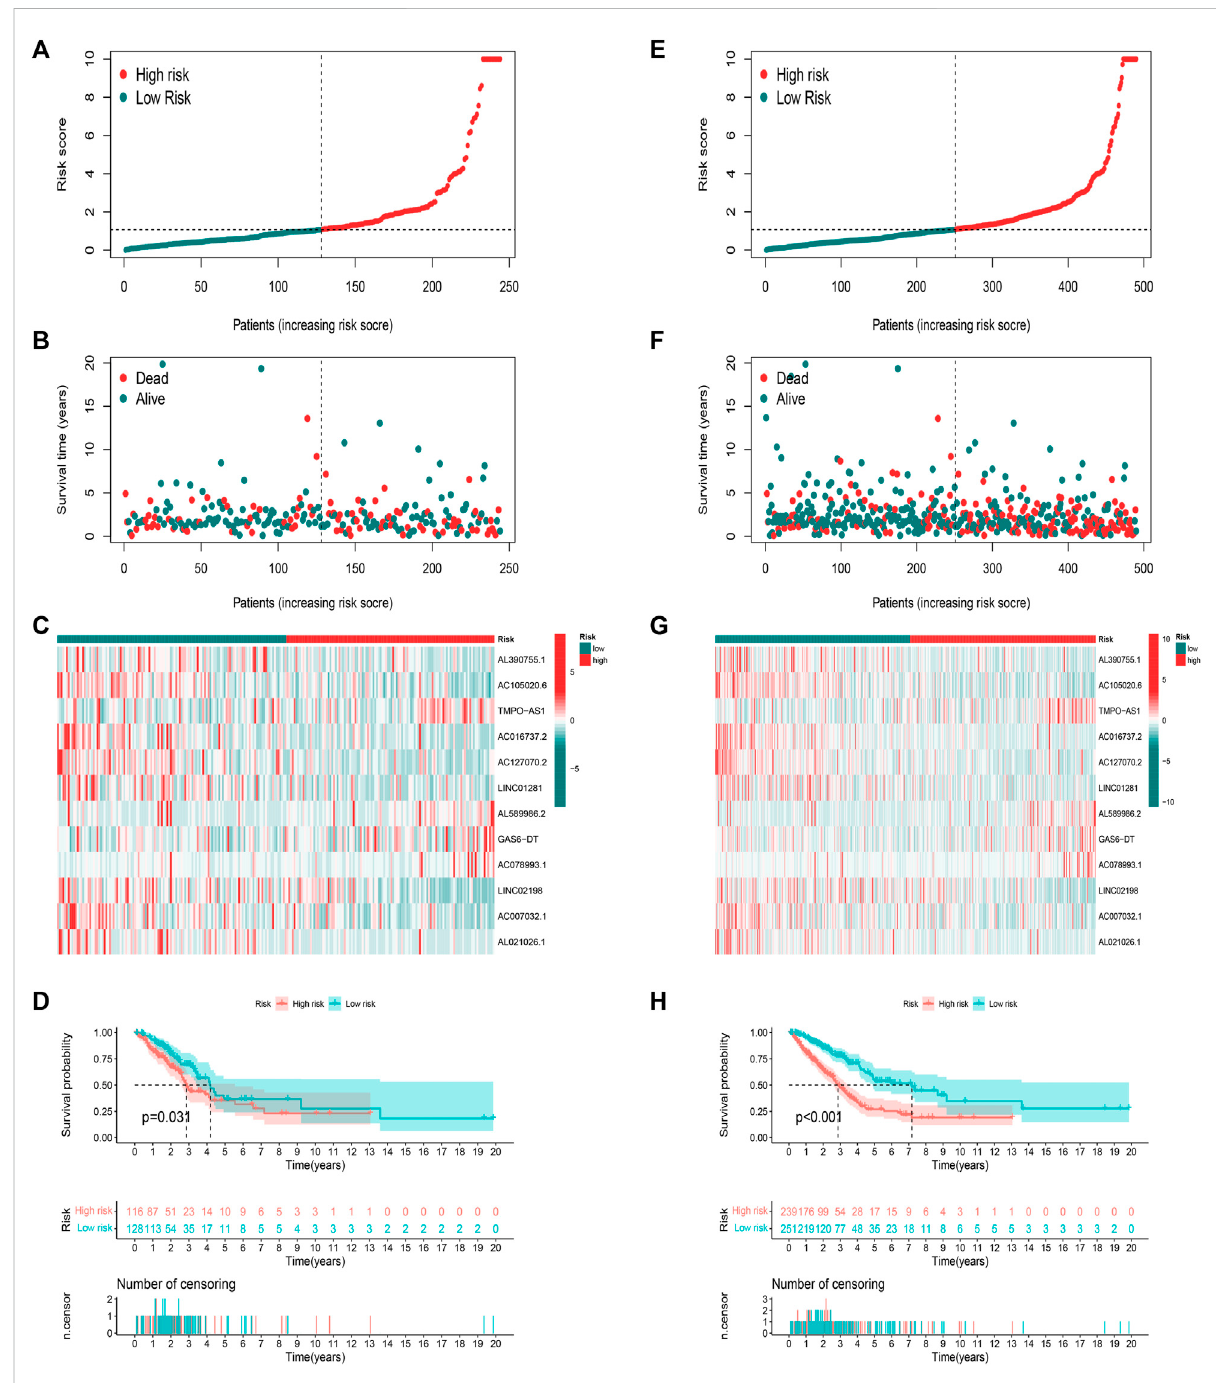
FIGURE 4 Prognostic value of risk score model in testing and entire sets. (A – D) Distribution of risk score, survival status, 12 hub lncRNA expression levels, andK-Msurvivalcurve(OS)inthetestingset. (E – H) Distribution ofriskscore,survivalstatus, 12hublncRNA expression levels,and K-Msurvivalcurve (OS) in the entire